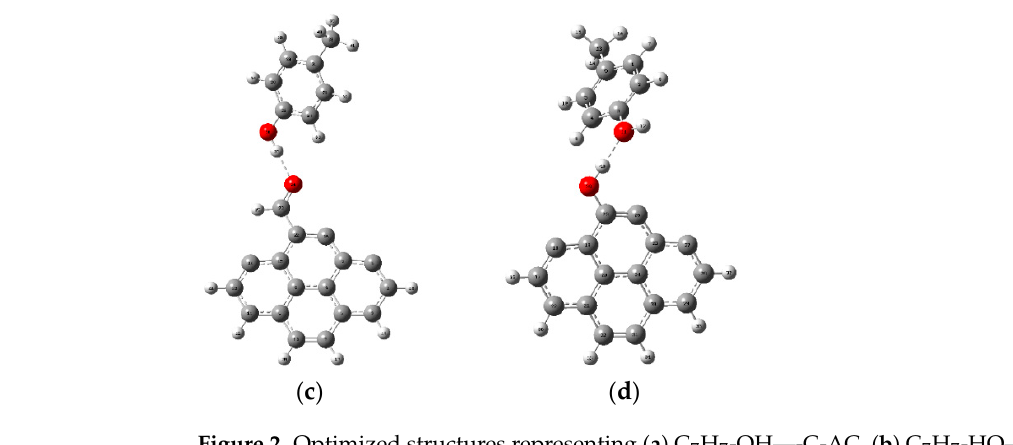
Figure 2. Optimized structures representing ( a ) C 7 H 7 -OH----C-AC, ( b ) C 7 H 7 -HO----HOOC-AC, ( c )